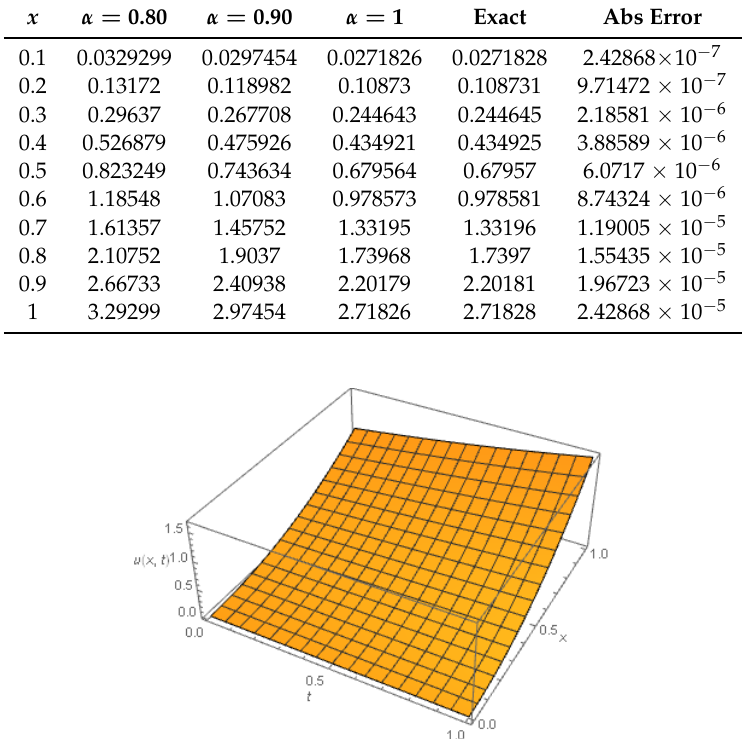
Figure 1:3D exact Solution of example1 Figure 6. 3D exact Solution of Example 2 with α = 1. with (cid:11) = 1